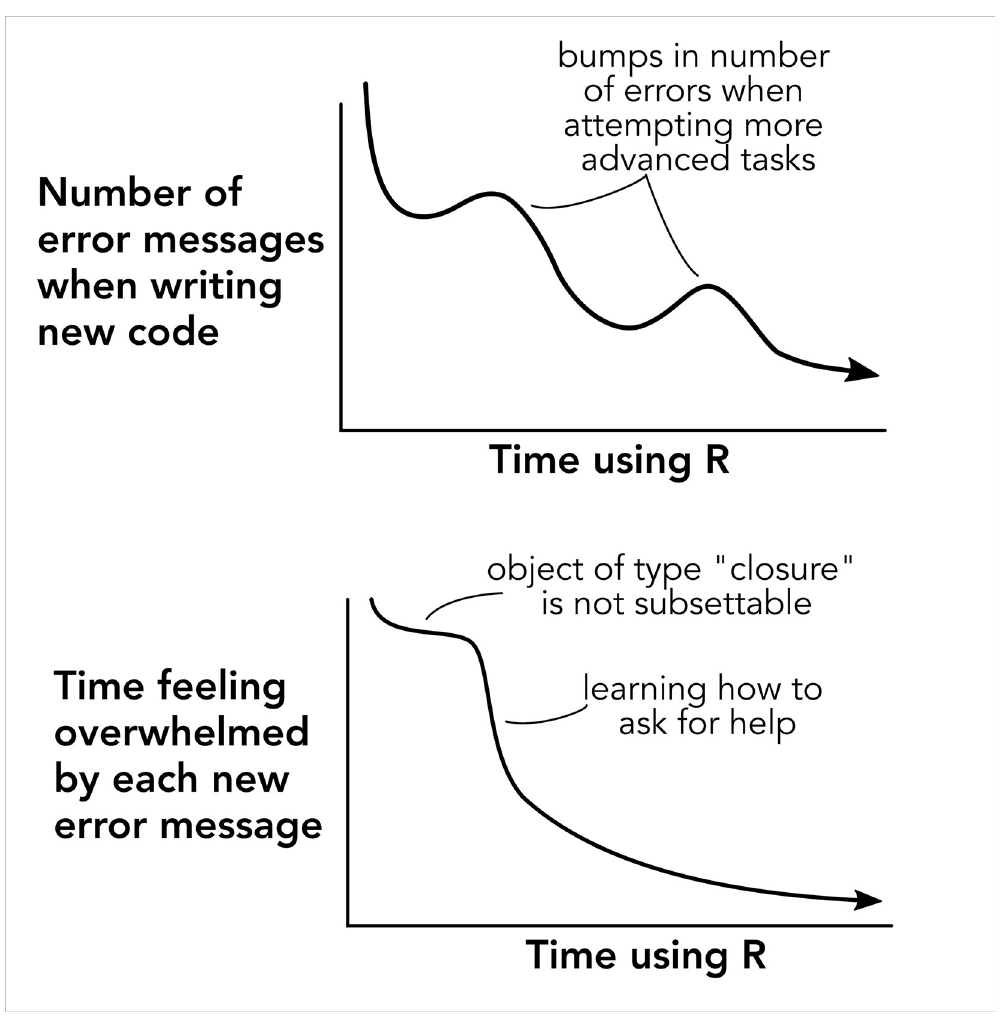
Fig 1. Proficiency in R isn’t about never making mistakes, but becoming comfortable encountering and solving them when you do.